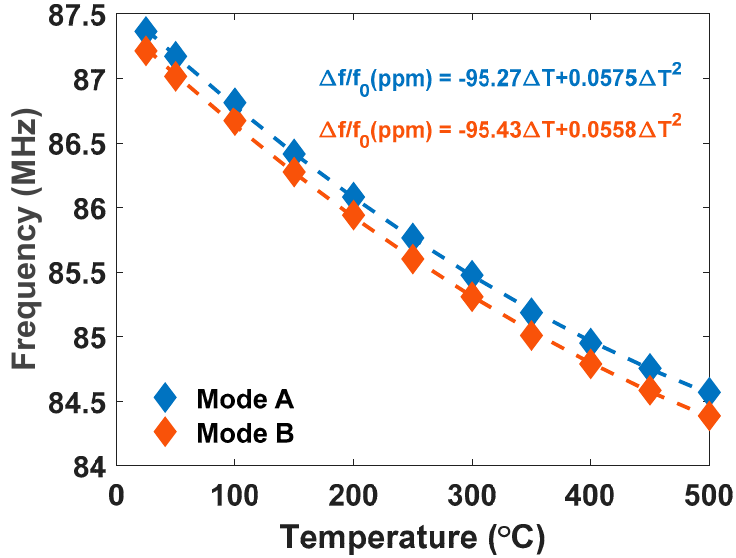
Figure 6. Measured temperature dependence of the shear horizontal (SH0) mode resonant frequencies up to 500 °C.